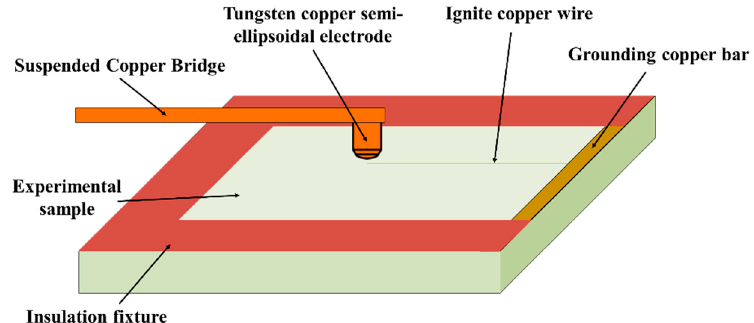
Figure 4. Schematic diagram of GFRC material along the surface ablation experiment layout. A pilot copper wire with a diameter of 0.4 mm was inserted vertically in the middle of the GFRC laminate. The length of the copper wire above the surface layer was 15 mm, and the distance between the discharge electrode and pilot copper wire was 2 mm. The grounding copper bar is placed below the test sample to form a current loop (see Figure 5).